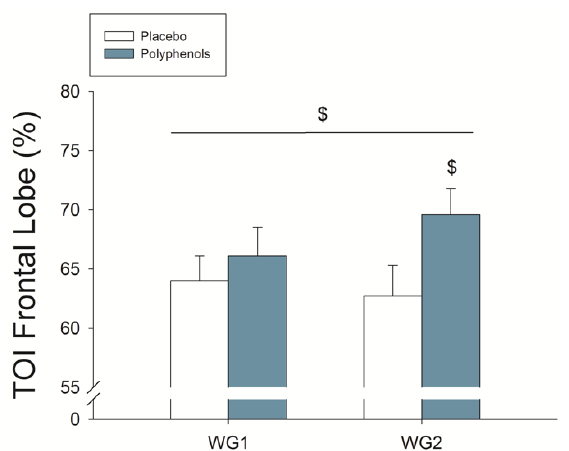
Figure 3. Frontal lobe oxygenation index (TOI) during the first two 30 s Wingate tests after the ingestion of polyphenols (luteolin + mangiferin) or placebo. Number 1 indicates after 48 h and 2 after 15 days of supplementation. $ p < 0.05 for treatment effect. N = 12.